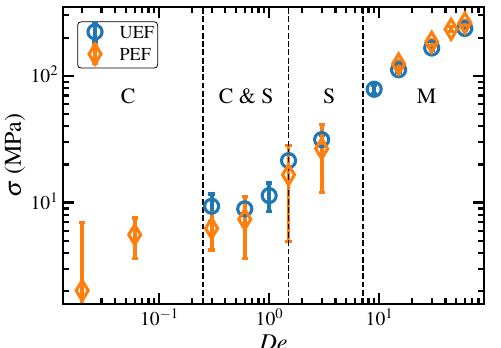
Figure 7. Nonequilibrium phase diagram of the C 1000 H 2002 melt under both steady-state UEF and PEF based on the extensional stress, σ , plotted vs. De . Upper-case Roman letters within the figure are described in the caption to Figure